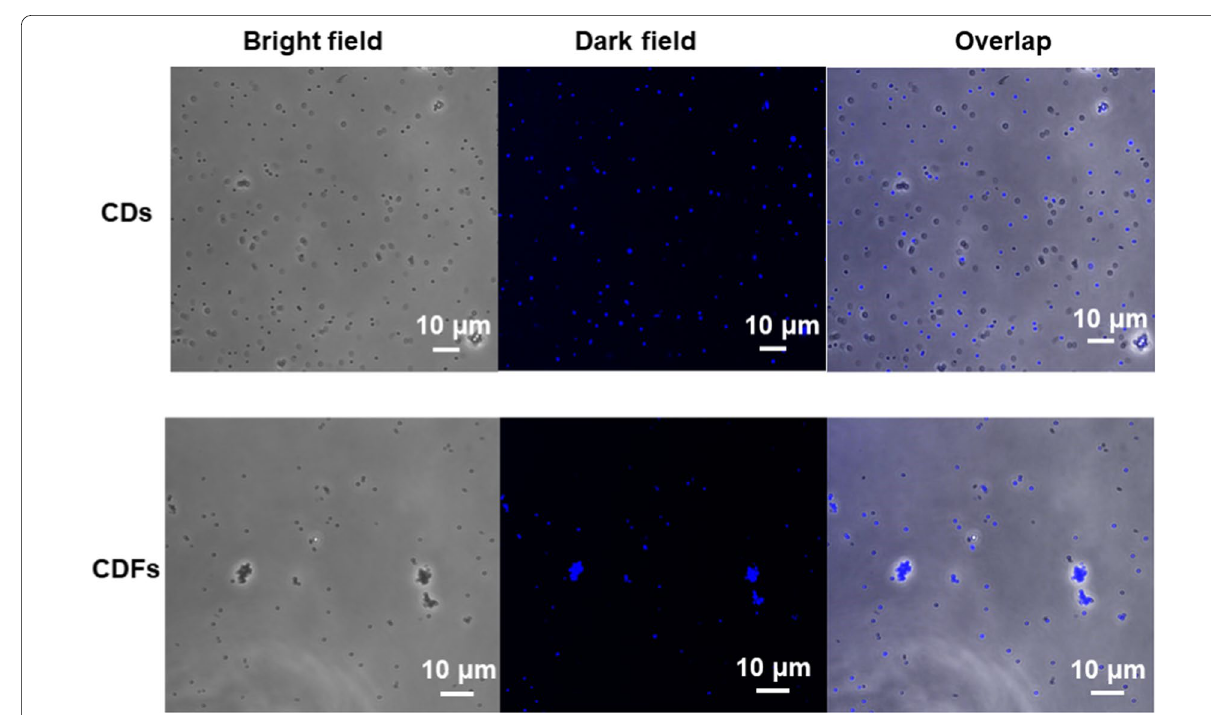
Fig. 9 Imaging of S. aureus by the uptake of CDs and CDFs after 12